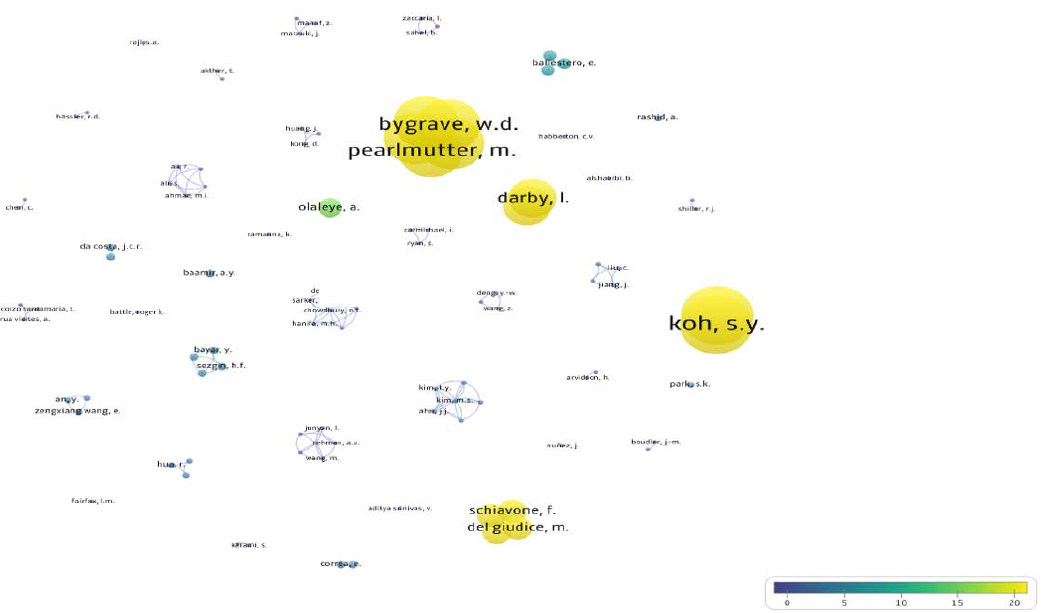
Figure 5. Visual representation of bibliographic coupling; Author.